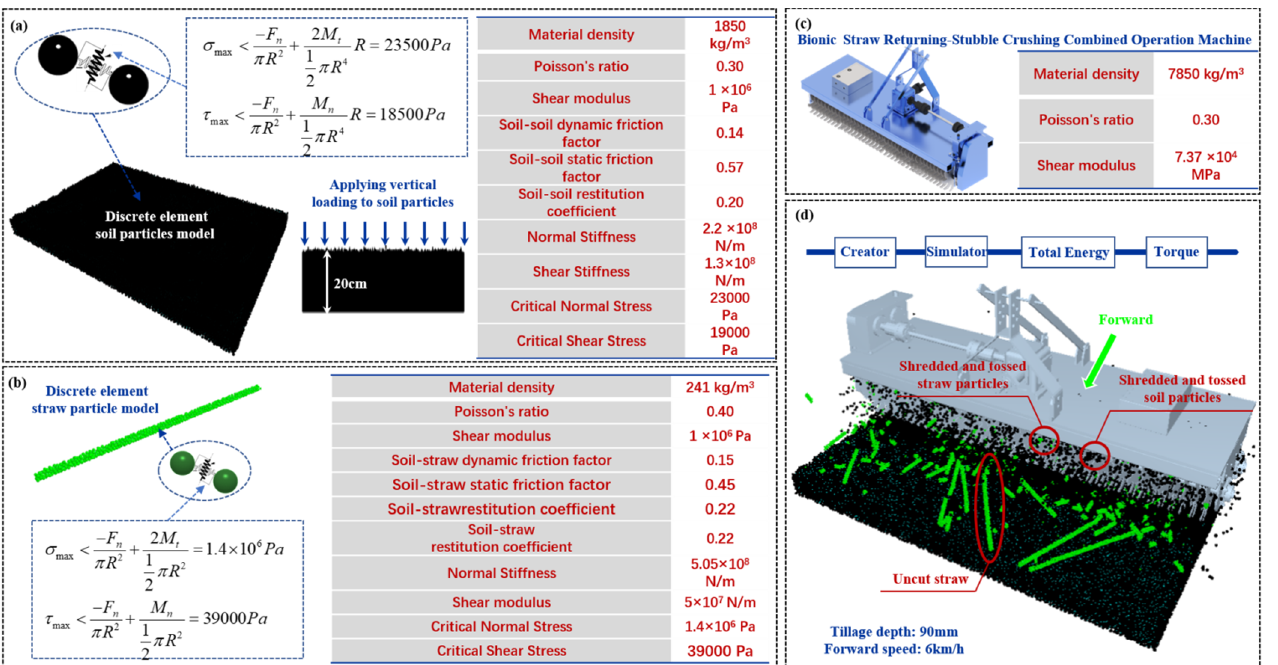
Figure 2. DEM simulation model construction and simulation operation process. ( a ) Discrete element soil model and parameter construction. ( b ) Discrete element maize straw model and parameter construction. ( c ) Construction of 3D model and parameters of the bionic straw returning machine. ( d ) The DEM-based simulation of the operation process of the bionic straw returning machine. Table 1. Bionic coupling element level and the test machines comparison